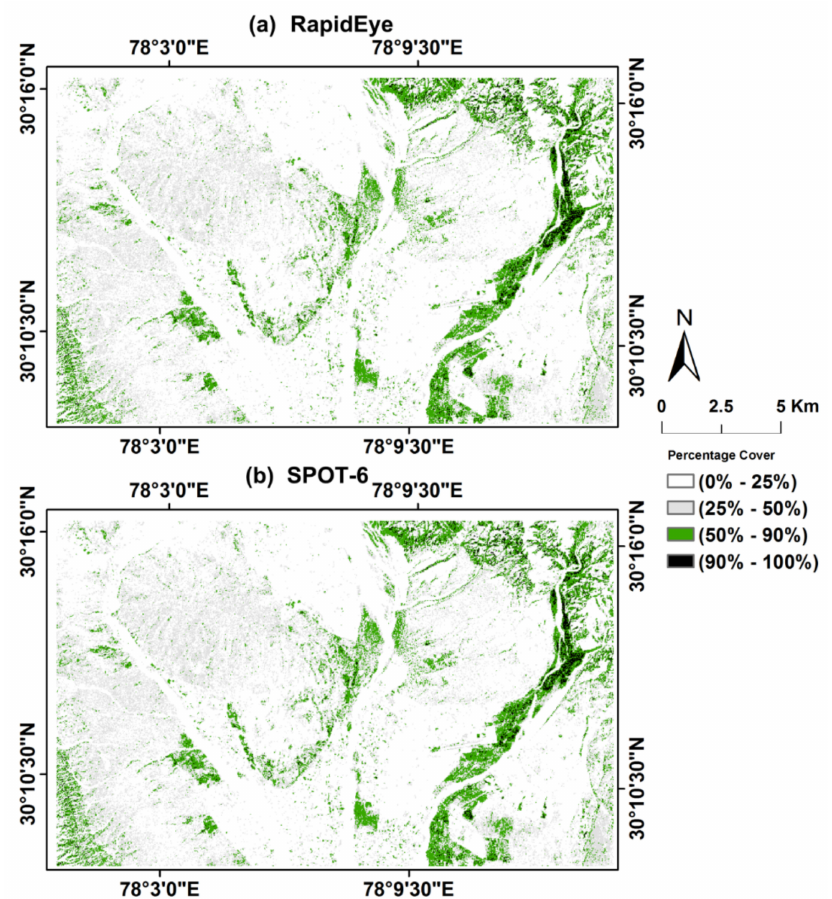
Figure 6. Landsat-8 classification for lantana within fractional cover thresholds (0%–25%, 25%–50%, 50%–90%, 90%–100%) for ( a ) RapidEye and ( b ) SPOT-6